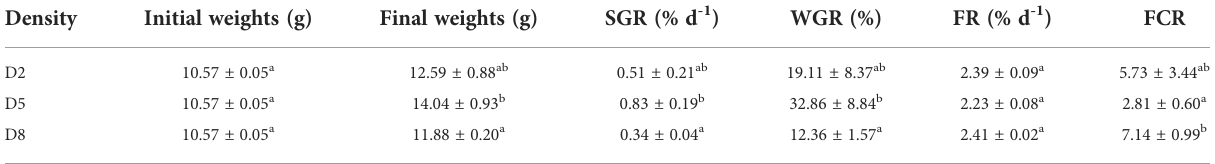
Data are mean ± S.D. and different letters in the same column represented signi fi cant differences with P <